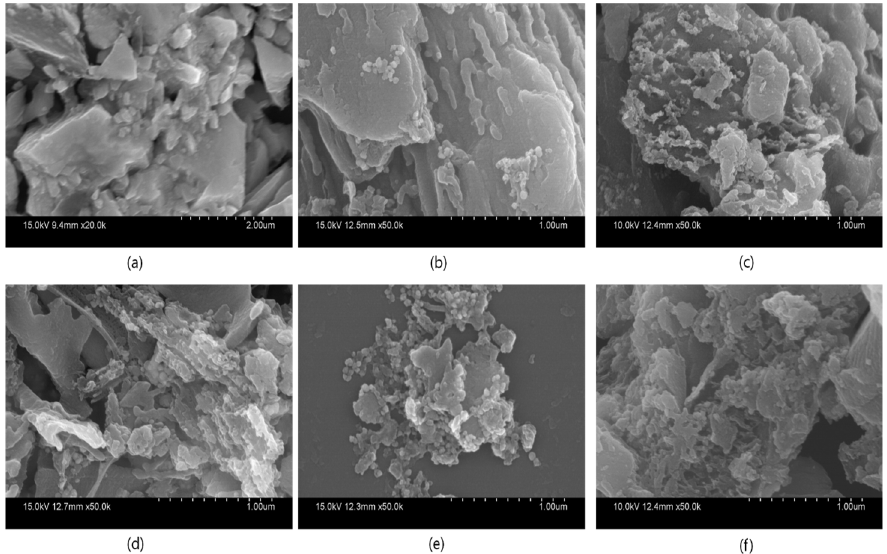
Figure 4. Scanning electron microscopy images of pure and Ag-loaded g-C 3 N 4 structures ( a ) g-C 3 N 4 and ( b ) 0.005 Ag/g-C 3 N 4 ( c ) 0.01 Ag/g-C 3 N 4 ( d ) 0.015 Ag/g-C 3 N 4 ( e ) 0.02 Ag/g-C 3 N 4 and ( f ) 0.025 Ag/g-C 3 N 4 structures.